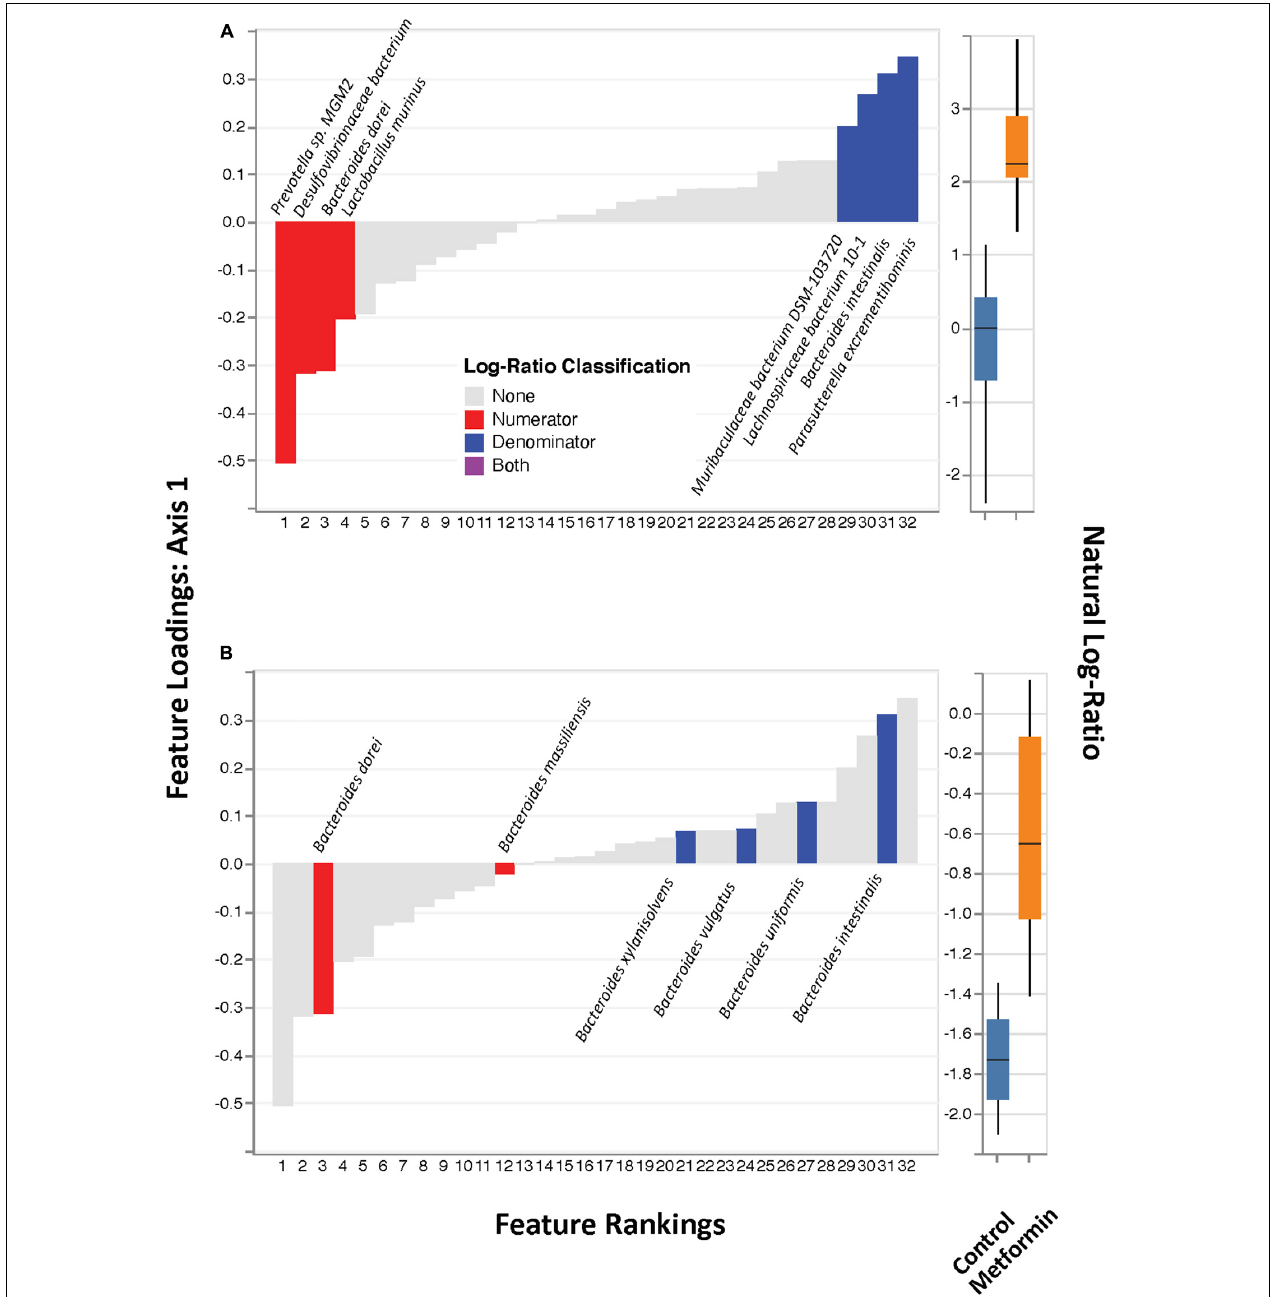
FIGURE 2 | DEICODE feature rankings. (A) Same plot as in Figure 1 , with only the top-feature rankings selected (left), and their ratios plotted as a box-whisker-plot (right). (B) Only Bacteroides spp. selected (left) and their ratios plotted as box-whisker plot